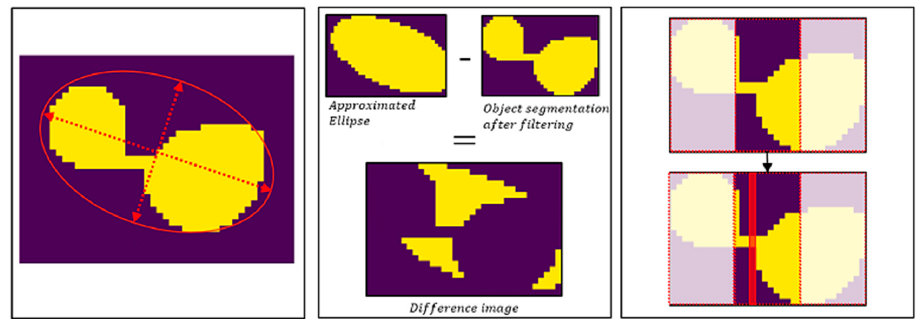
Figure 4. Illustration of the tested conditions for object splitting (left and middle), as well as the implementation for multi- fruit object separation.